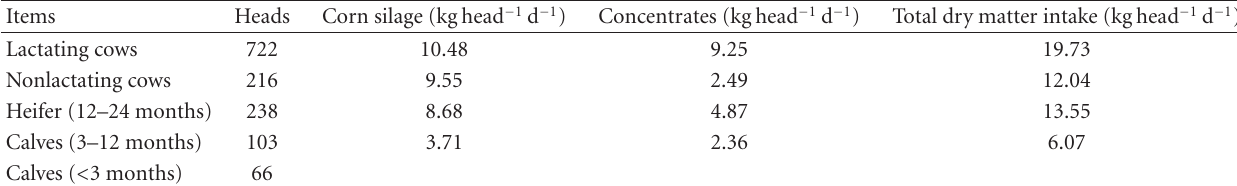
Table 2: Herd structure and feed composition during the four